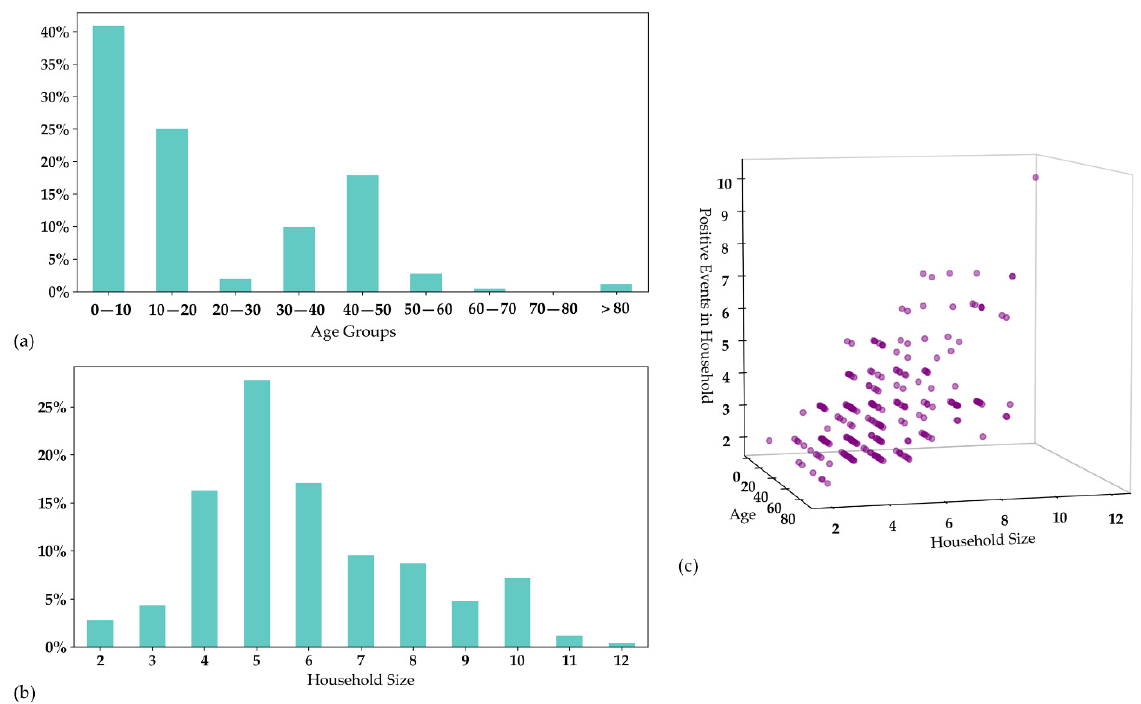
Figure 3. ( a ) The age groups of the people designated as TEFLONs (Timely Exposed to Family members Leaving One Not infected). The X axis shows the age groups. The Y axis demonstrates the relative proportion of each age group of the entire TEFLON population. ( b ) The household sizes of the TEFLONs. ( c ) The relation between household size and the number of positive events. The X axis shows household sizes, the Y axis shows the ages of the persons designated as TEFLONs and the Z axis shows counts of individual positive events in each household.